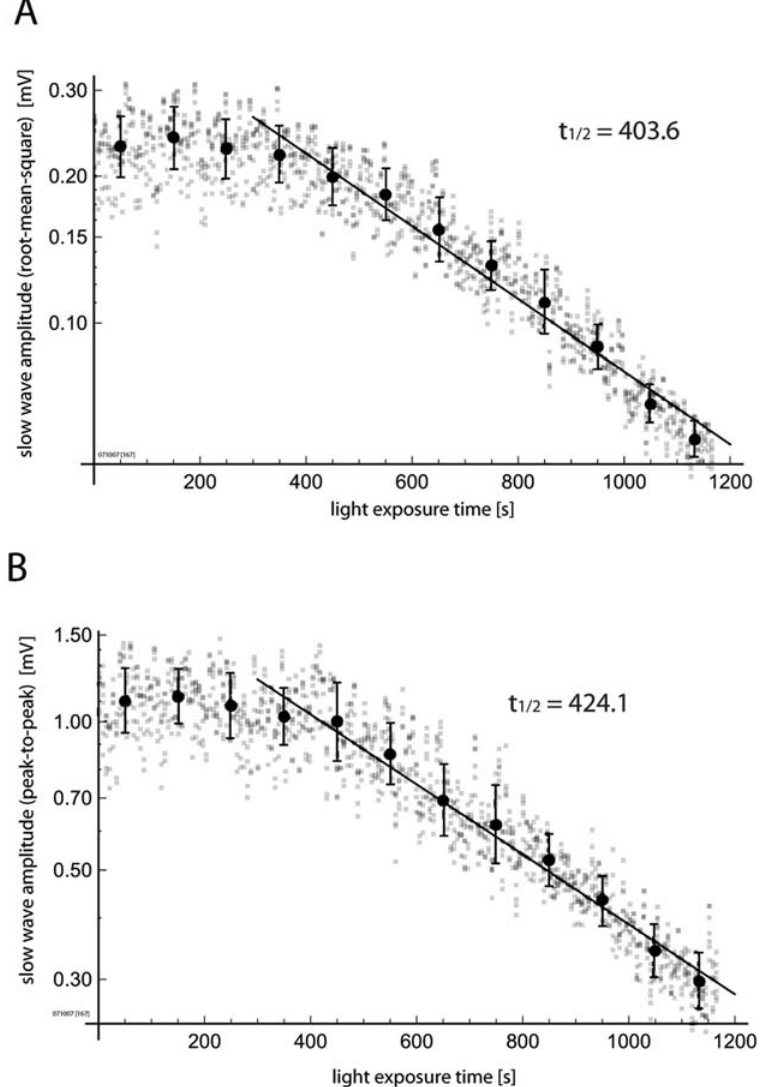
Figure 7. Non-epileptiform functional signal shows similar ‘‘bleaching’’ as epileptiform signal. The ‘‘bleaching’’ of spontaneous sleep- like slow wave activity was accessed under stable isoflurane anesthesia. A. Root-mean-square power of the slow wave activity. B. Peak-to-peak amplitude of the slow wave activity. Both measures show ‘‘bleaching’’ kinetics similar to those observed with epileptiform activity ( D F epileptiform ).